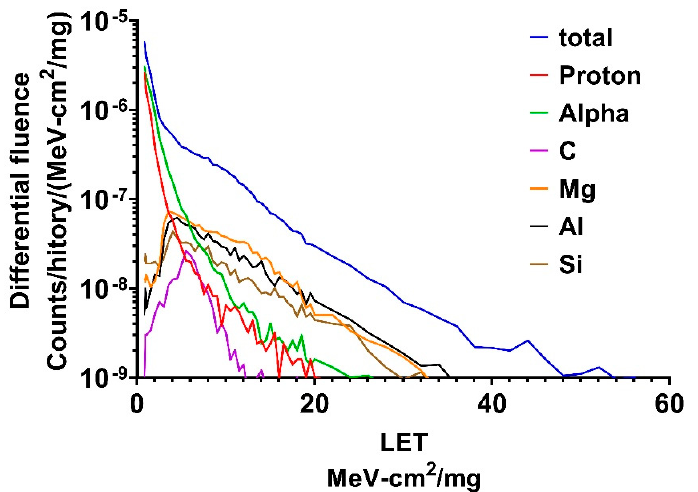
Figure 5. y spectra in 100 nm silicon irradiated by a 200 MeV proton beam.